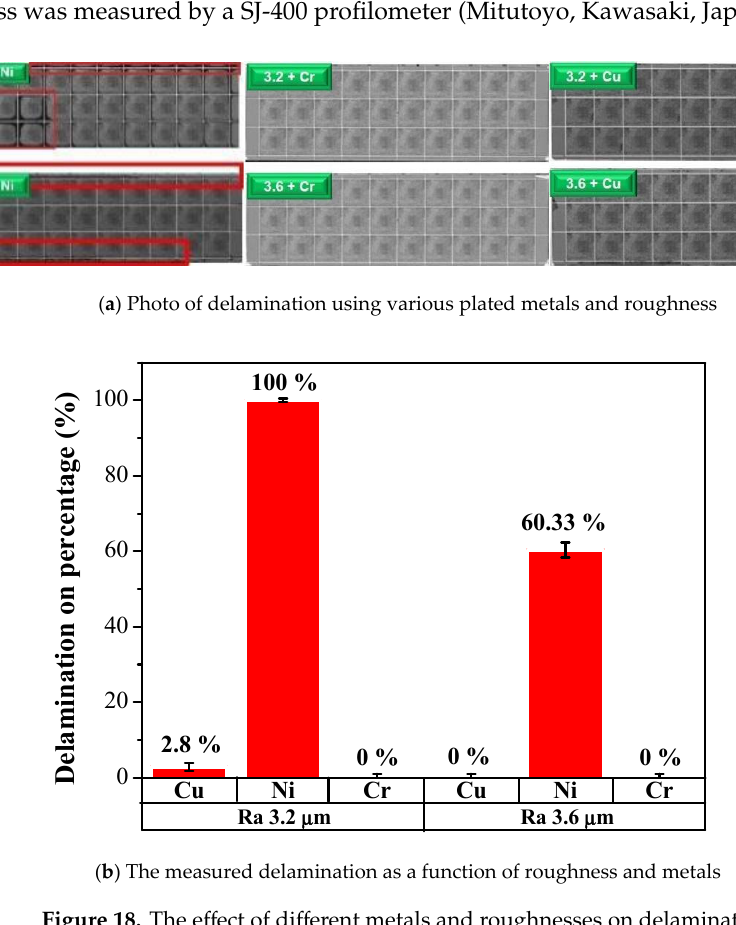
Figure 18. The effect of different metals and roughnesses on delamination.